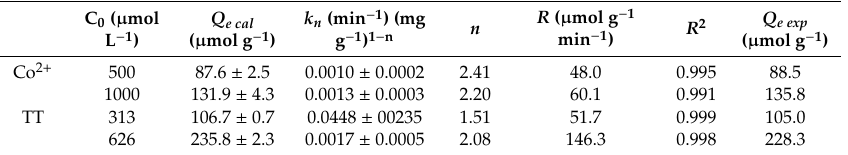
Table 1. Kinetic parameters of Co 2 + and thioflavin T (TT) adsorption for magnetically responsive biosorbent calculated from a pseudo- n -order model using nonlinear regression